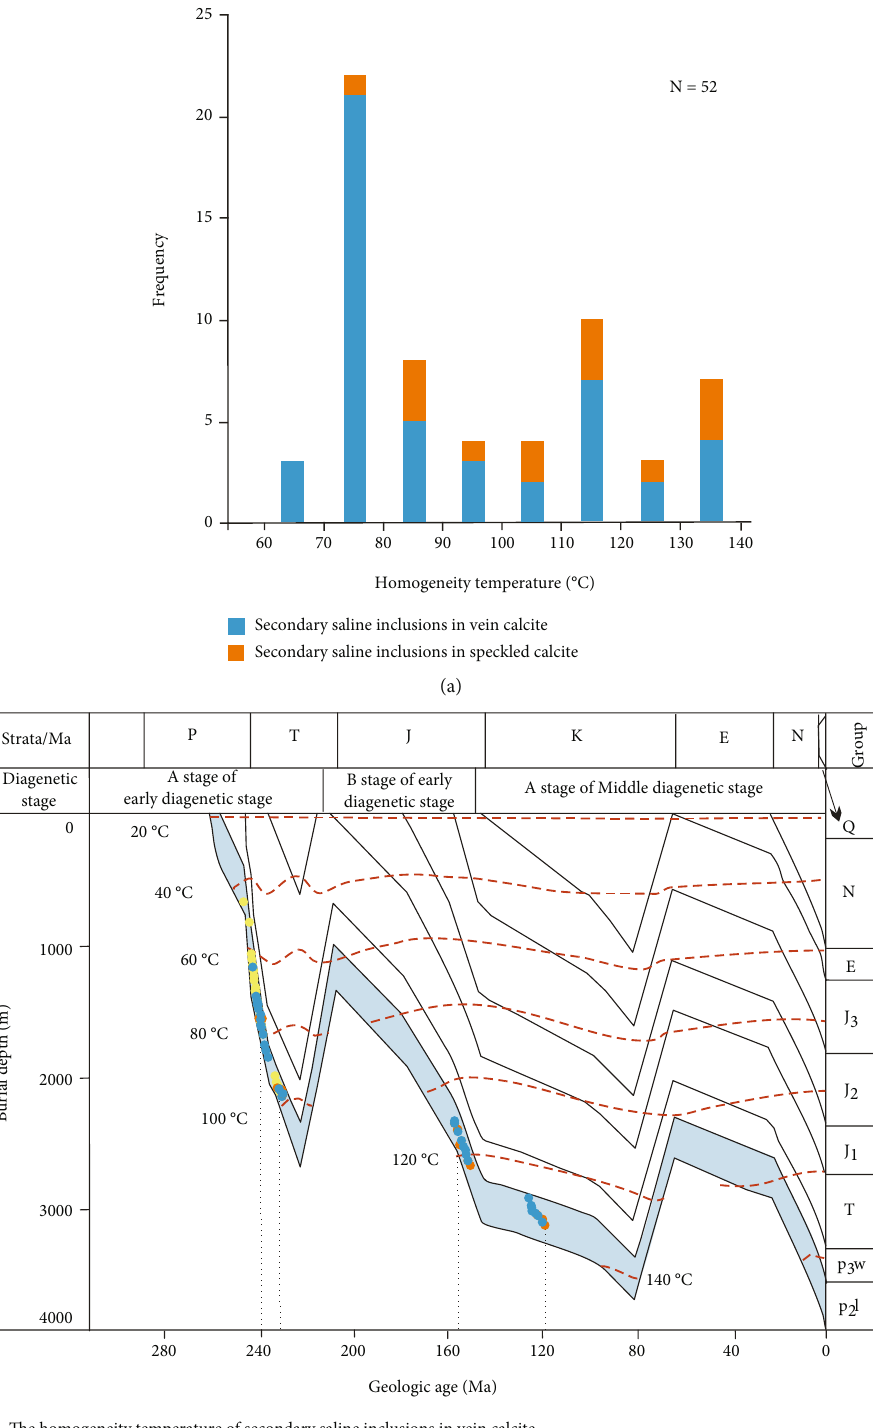
Figure 10: Histogram of homogenization temperature of secondary saline inclusions (a). Projection of burial history and thermal evolution in Jimsar Depression